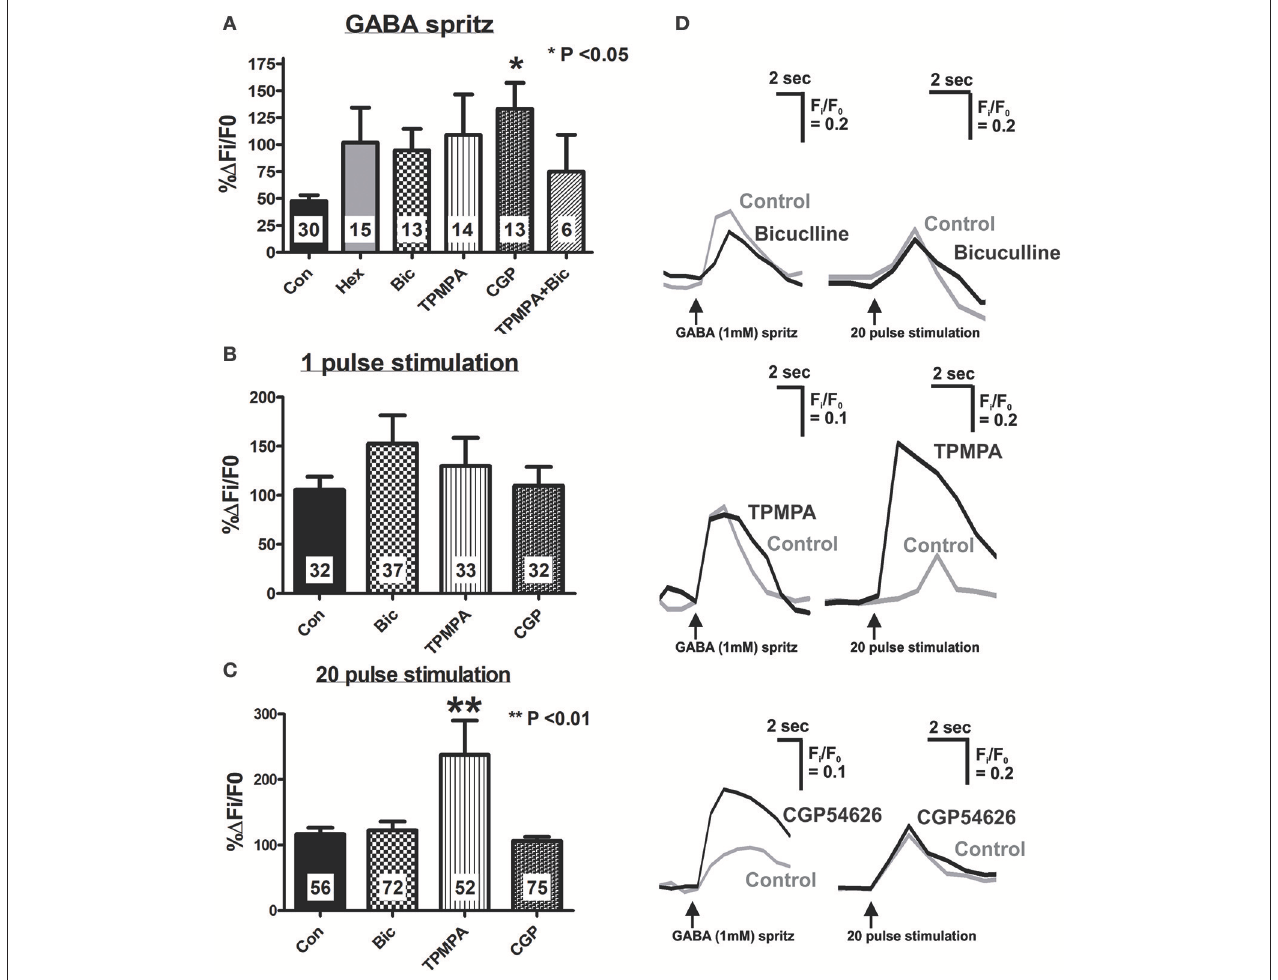
FIGURE 3 | Effect of specific antagonists on GABA- and electrically-evoked [Ca 2 + ] i transients. Neurons were stimulated twice, first in the present of control saline, and second after 10min application of antagonists (Hexamethonium, Hex 100 µ M; Bicuculline, Bic 10 µ M; TPMPA, 100 µ M; CGP54626, CGP 1 µ M or a combination of antagonists). Time controls were also performed (Con) where both stimuli were executed in control saline, 10min apart. Histograms summarizing the pooled dataset from all neurons stimulated with GABA (1mM) (A) , single pulse (B) or a train of 20 pulses (C) , excluding those that were abolished in the presence of antagonists (see Tables 2 , 3 ). Changes in amplitude after application of various antagonists are presented as a percentage of the first response in control saline. (A) CGP54626